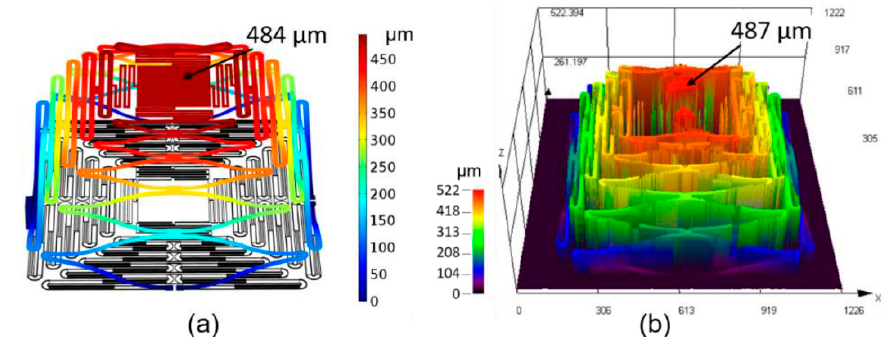
Figure 3. Comparison of the initial elevation due to residual stress and the CTE mismatch from our FEM solution and our 3D measurement (scales are in µm): ( a ) FEM model of a full actuator system with an initial elevation of the platform of 484 µm; ( b ) 3D result of the released structure, where the platform has an initial elevation of 487 µm.